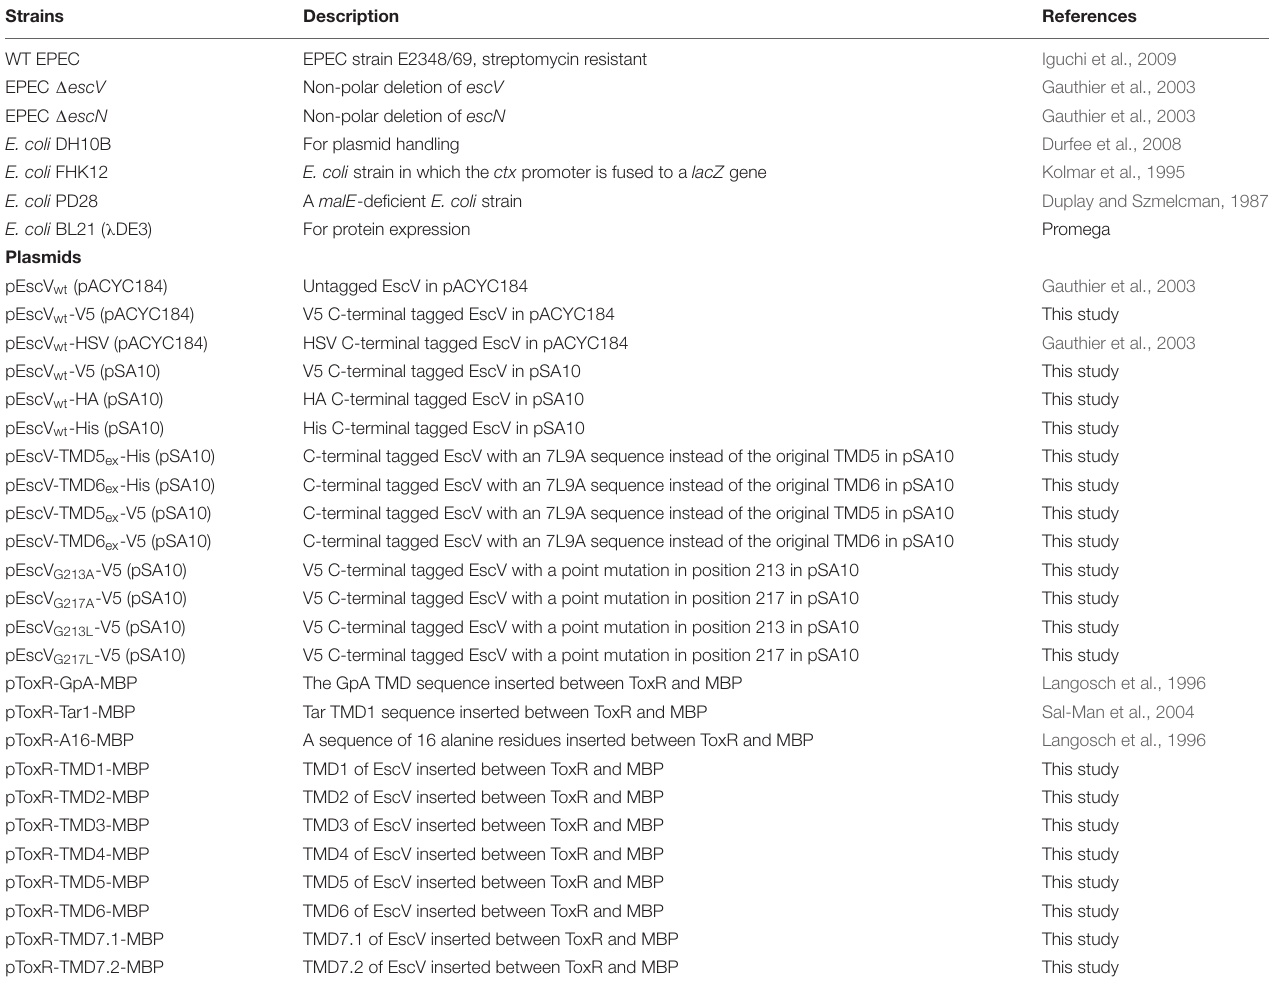
TABLE 1 | Strains and plasmids used in this